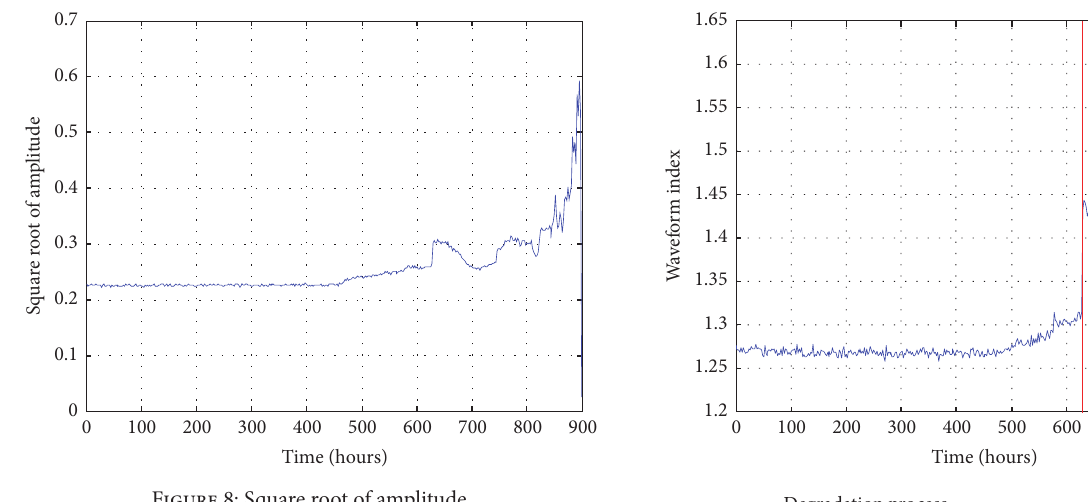
Figure 8: Square root of amplitude.